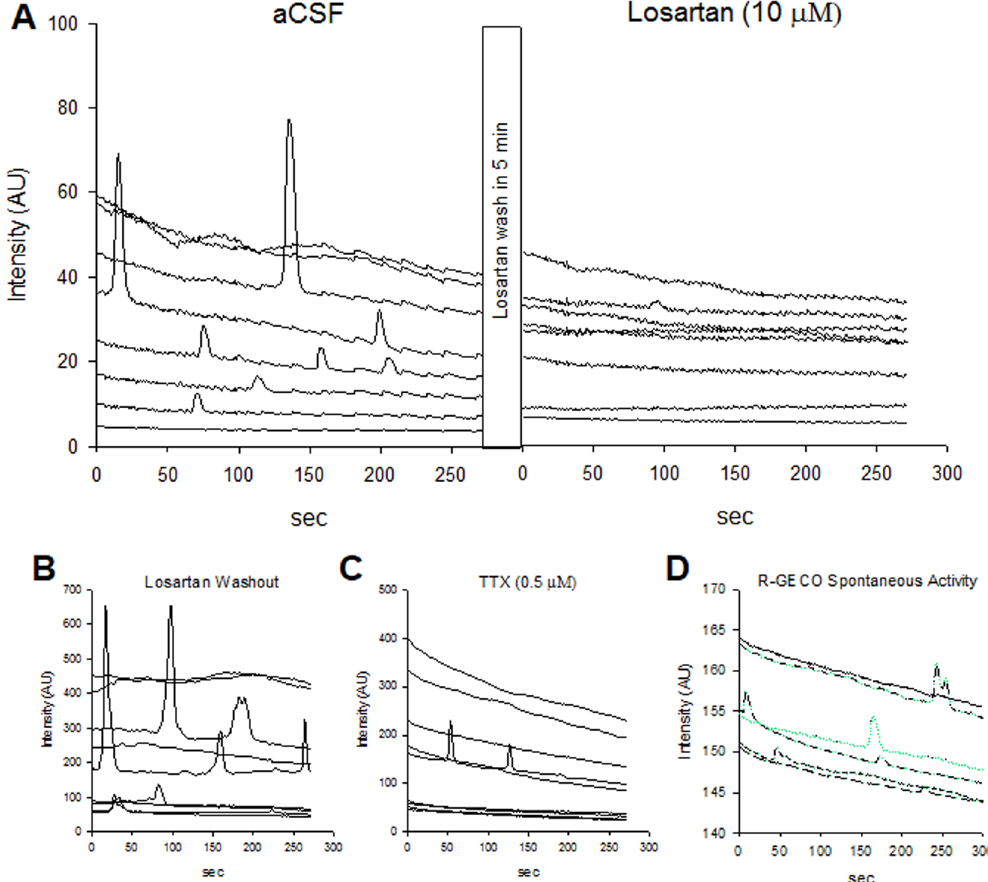
Figure 3. Sniffer cells exhibit spontaneous increases in fluorescence on in vitro brain slices. ( A ) GCaMP + AT1aR sniffer cells placed on the MnPO exhibit spontaneous increases in fluorescence that are completely blocked by bath application of Losartan (10 µ M). ( B ) Spontaneous sniffer cell responses return following washout of bath applied Losartan. ( C ) Bath application of TTX (1 µ M) was also effective in reducing the number of spontaneous sniffer cell responses. ( D ) R-GECO + AT1aR sniffer cells also exhibit spontaneous increases in fluorescence on in vitro brain slices. Each trace represents an individual sniffer